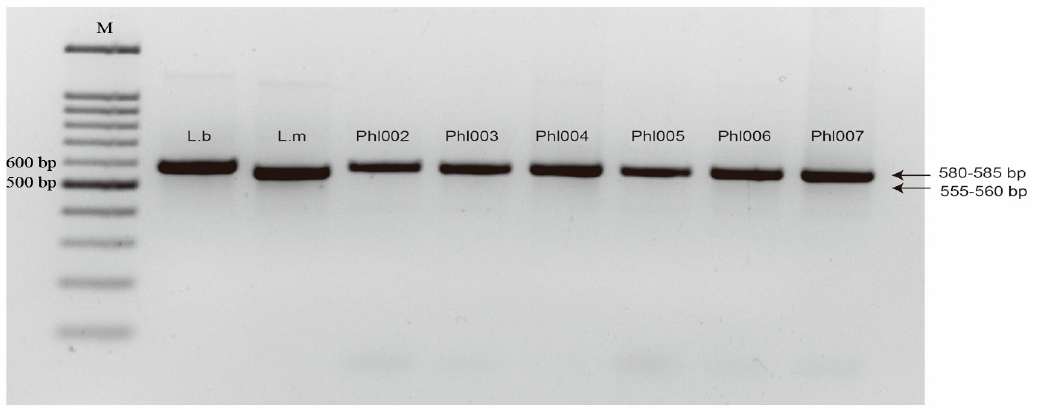
Figure 2. PCR identification of a Leptosphaeria complex with the primers, PN3 and PN10, using genomic DNA of isolates Phl002 to Phl007 obtained from an organic vegetable Brassica rapa seed crop of the cv., Mizspoona, grown in the Willamette Valley of Oregon. Lb. and Lm. were reference isolates for the 555 to 560 bp and 580 to 585 bp amplified bands of L. biglobosa and L. maculans isolates, respectively. M, 100 bp DNA ladder.